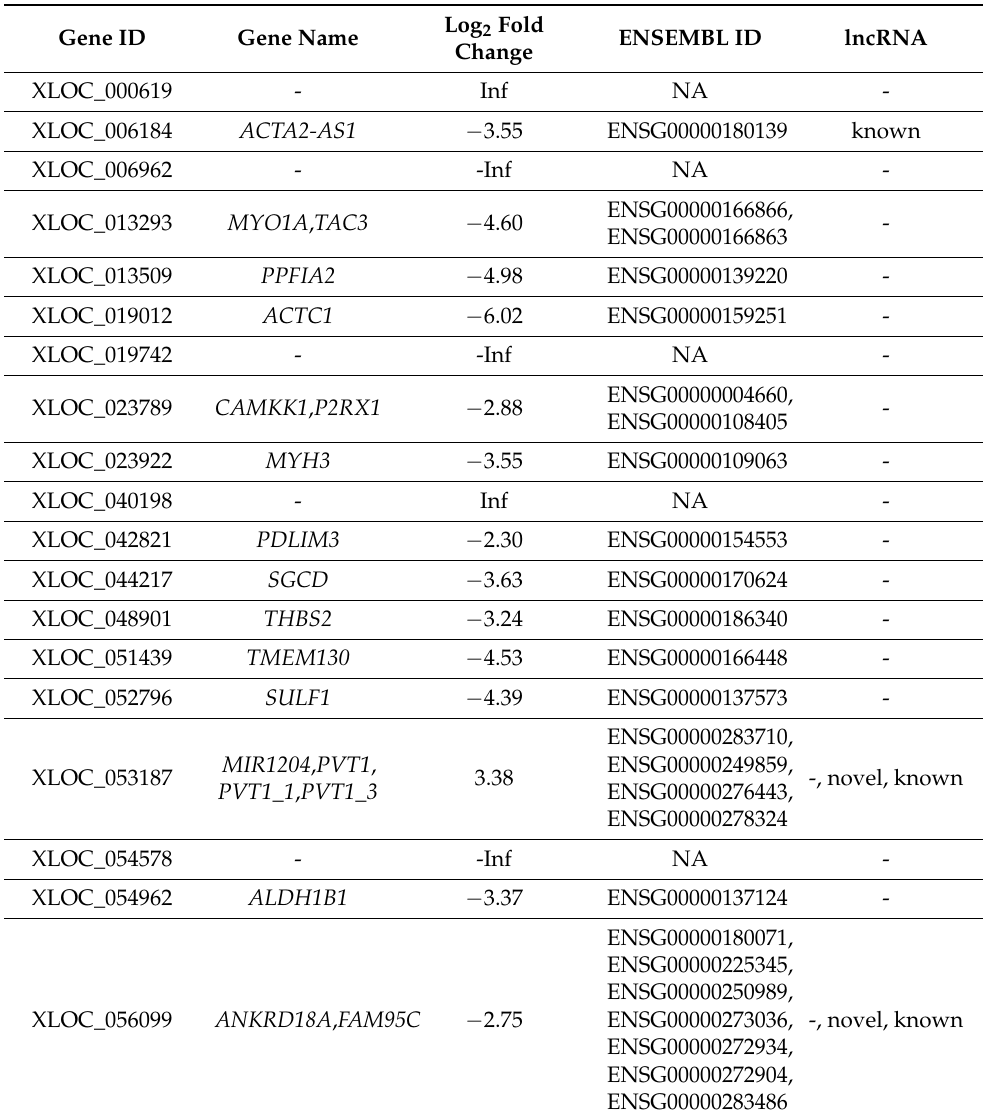
Table 3. Differentially expressed genes identified in ff-FGR samples. Normalized fold changes (log 2 fold change) were calculated on the locus level (XLOC). Loci containing lncRNAs are marked in the “lncRNA” column as known (referring to annotated lncRNA) and novel (referring to lncRNAs identified in this study). “-” in the “lncRNA” column means that in this specific locus, lncRNA has not been